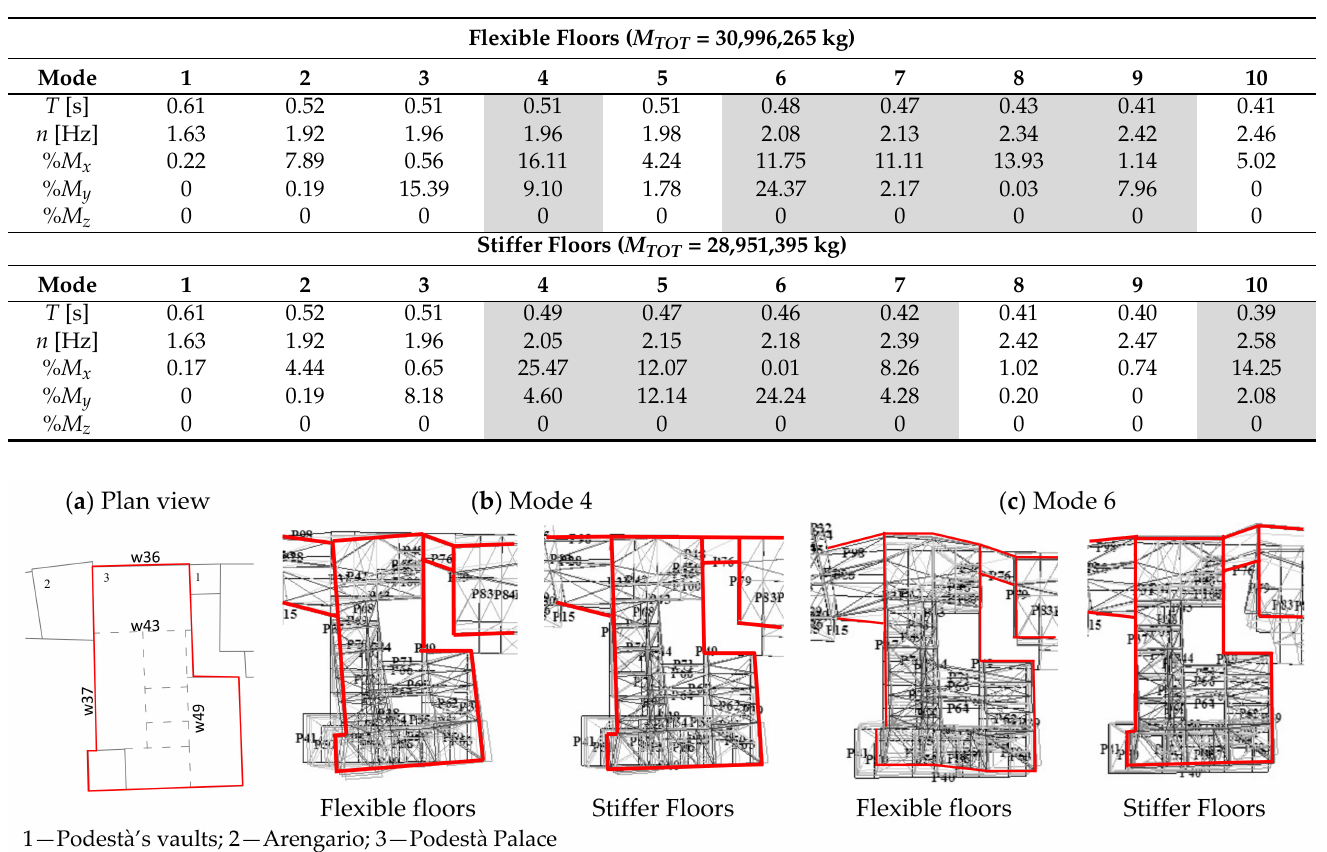
Table 4. Results of the modal analysis configurations with flexible and stiffer floors.